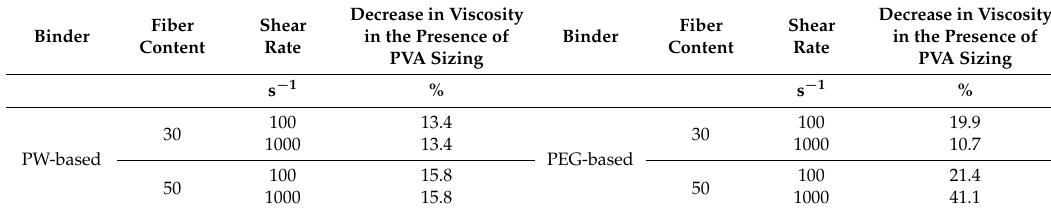
Table 5. The effect of PVA sizing on viscosities of different feedstock combinations.